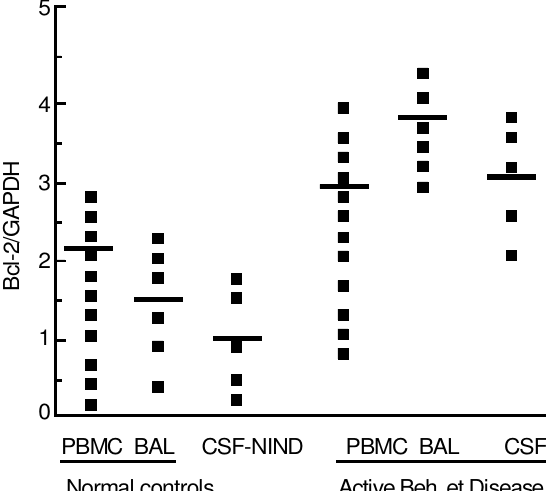
FIG. 2. Results of double staining experiments on the lymphocytes of representative bronchoalveolar lavage from patients with active Behçet’s disease with pulmonary mani- festations. Freshly isolated lymphocytes were stained with FITC-conjugated anti-human CD3 monoclonal antibody. Fol- lowing this step cells were permeabilized and then stained with biotinylated polyclonal rabbit IgG anti-human Bcl-2, as described in Patients and Methods. As control for the expression of Bcl-2, cells were incubated with biotinylated rabbit IgG and then with PE-conjugated streptavidin.